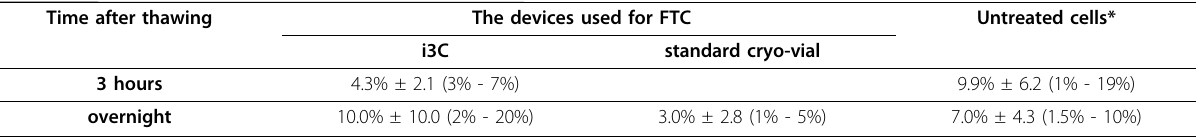
Table 2 Early apoptosis events in U937 cells after the freezing - thawing cycle Time after thawing The devices used for